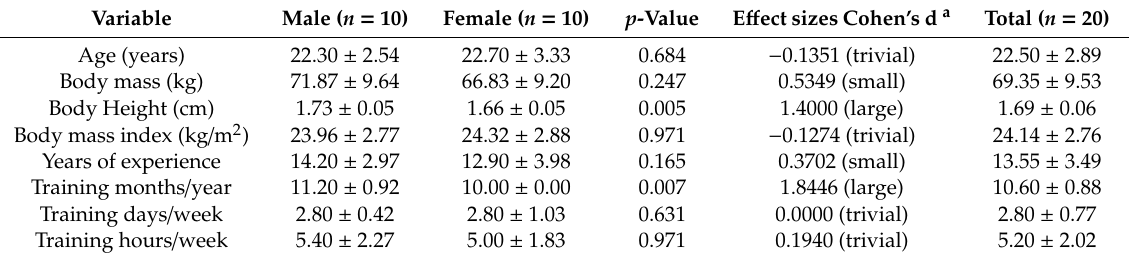
Table 1. Demographic and training regimen data of the Spanish National Teams’ inline hockey